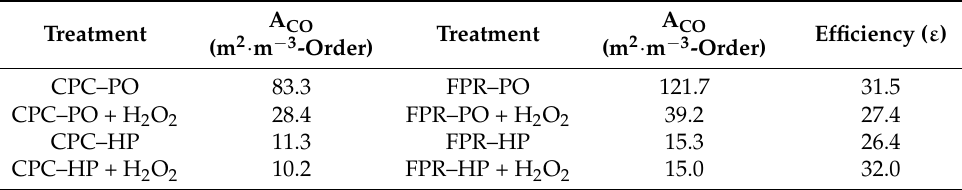
Table 8. Estimation of A CO for each treatment and comparative efficiency between reactors,